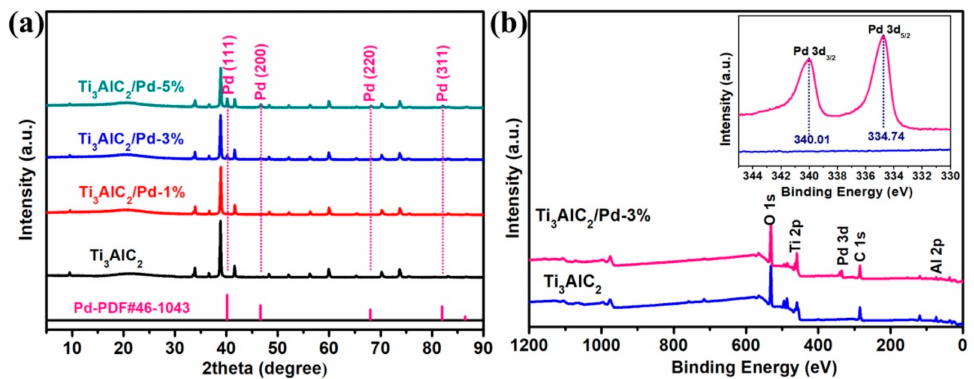
Figure 2. ( a ) XRD patterns of Ti 3 AlC 2 and Ti 3 AlC 2 /Pd composites with different Pd contents; ( b ) XPS survey spectra of Ti 3 AlC 2 and Ti 3 AlC 2 /Pd-3% composites, insert is the high-resolution XPS spectra of Pd